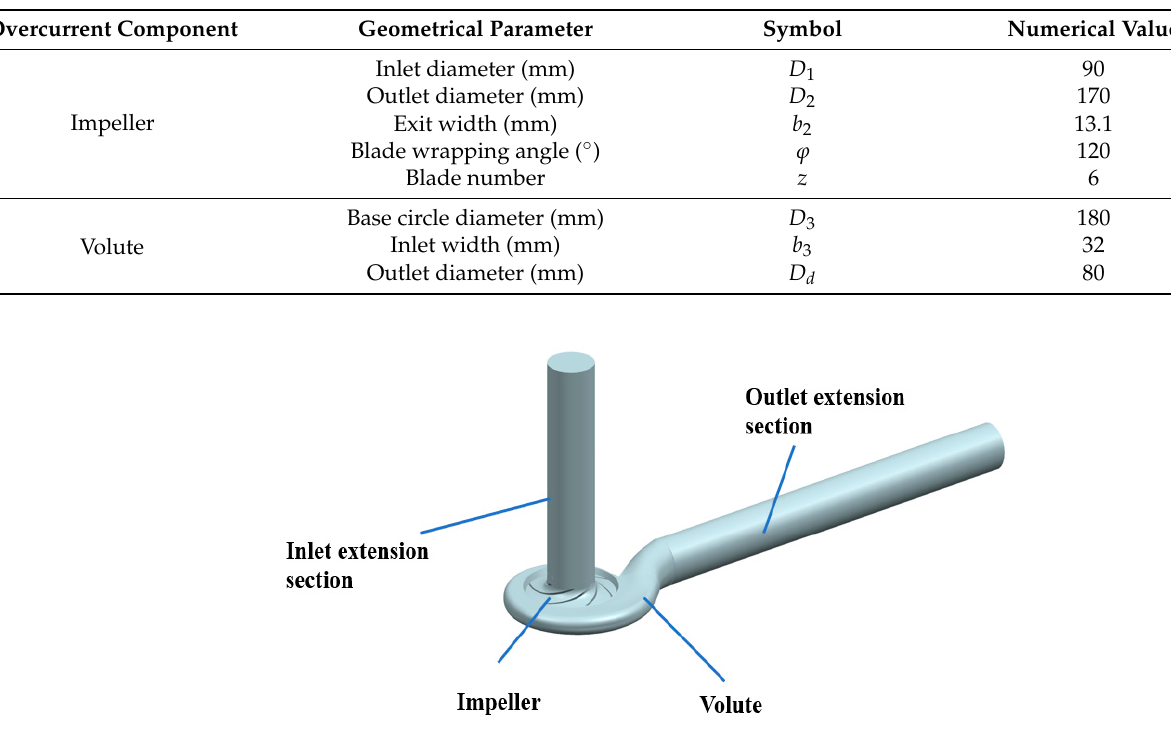
Figure 1. Three-dimensional model of calculated domain.